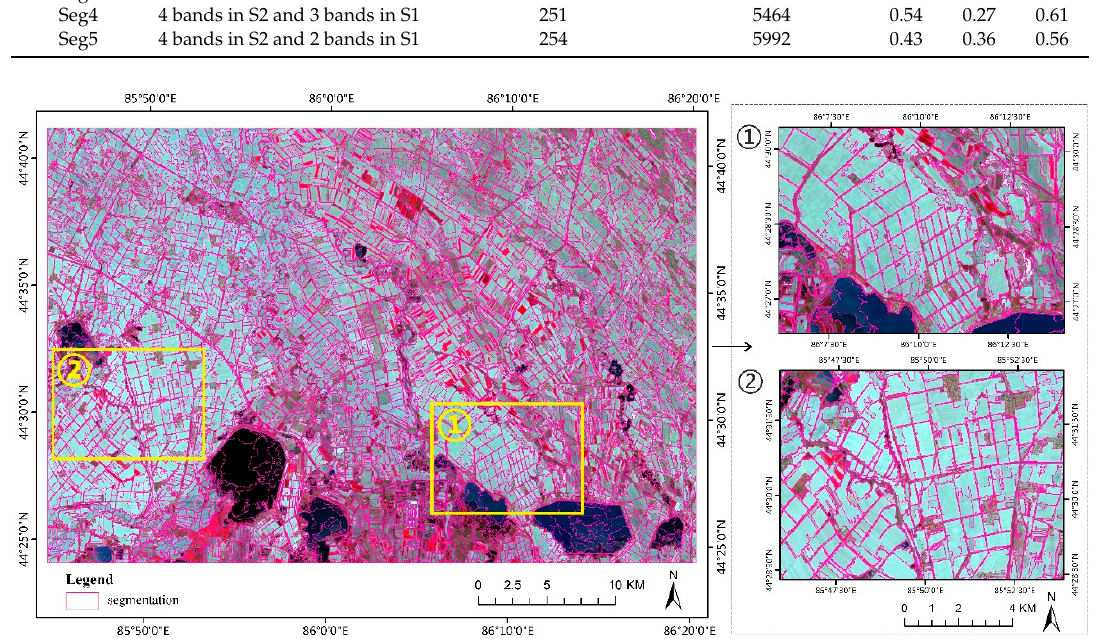
Figure 5. The best segmentation results: using four original 10 m-resolution bands in Sentinel-2 and two bands (VH_db, VV_db) in Sentinel-1. Scale parameter: 254.